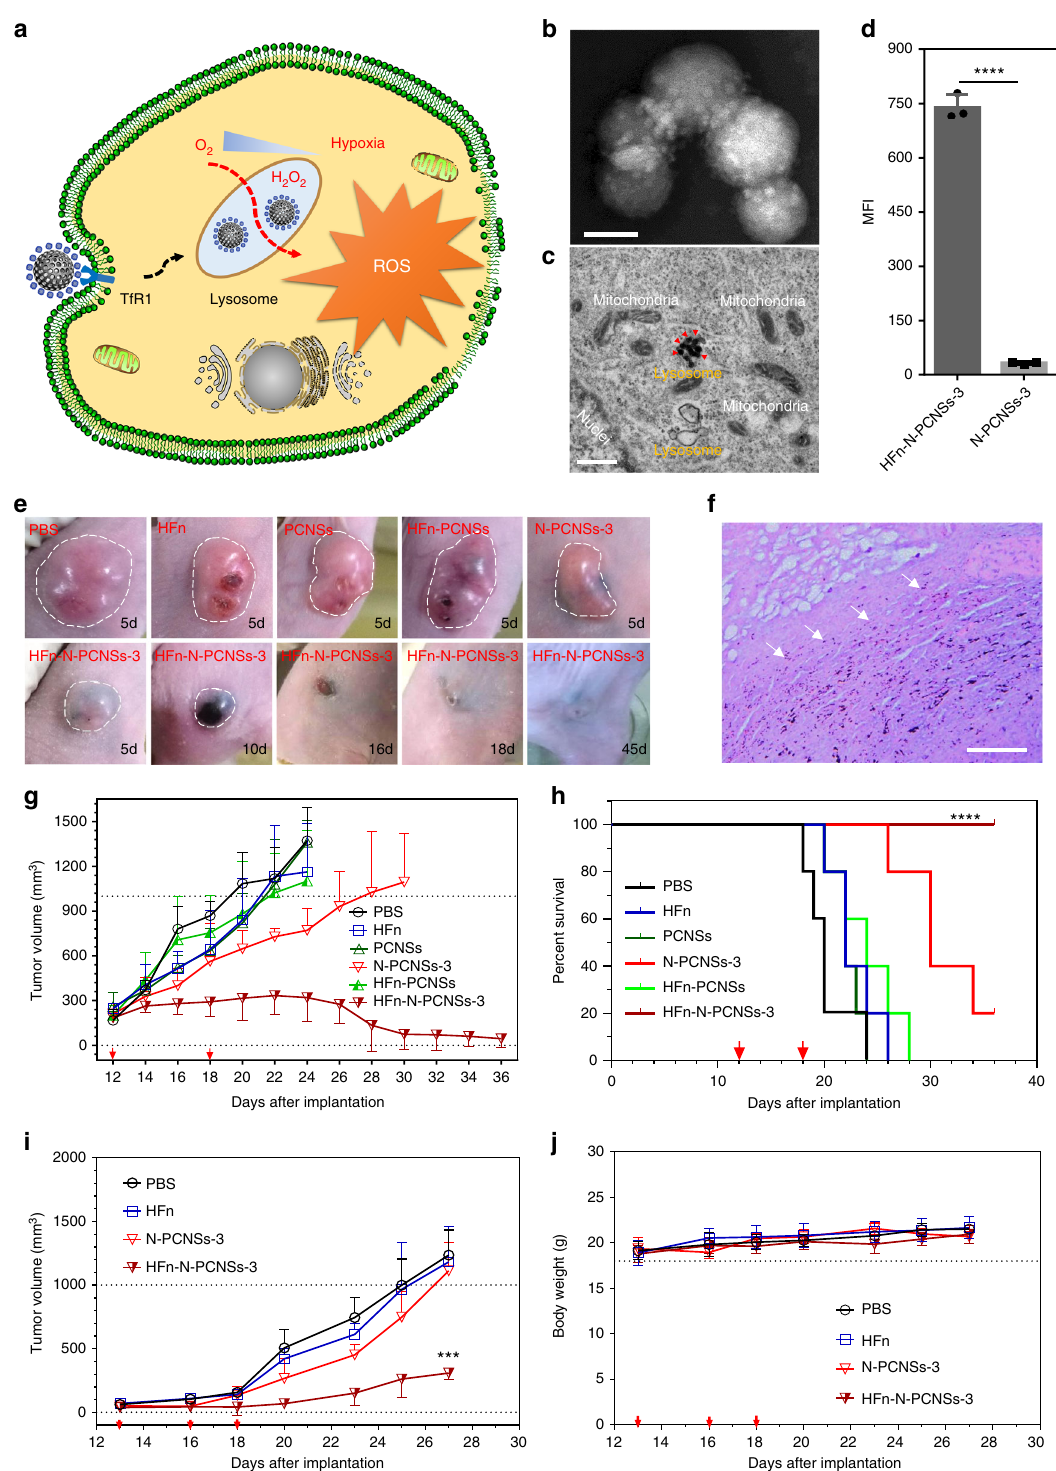
Fig. 4 Tumor therapy based on N-PCNSs using HFn coordination. a Schematic for N-PCNSs induced tumor cell destruction via ferritin-mediated speci fi c delivery. b TEM image of HFn assembled onto N-PCNSs. Scale bar: 50 nm. c TEM image of cancer cells treated with HFn-PCNSs. Red arrows indicate the position of HFn-PCNSs. Scale bar: 500 nm. d Quanti fi cation of HFn-enhanced internalization of N-PCNSs by fl ow cytometry analysis ( n = 3). Statistical signi fi cance is assessed by unpaired Student ’ s two-sided t -test compared to the control group. **** p < 0.0001. e Tumor morphology and progress with HFn-N-PCNSs treatment ( n = 5). f Accumulation of N-PCNSs in tumors. White arrow: edge of the tumor area. Scale bar: 200 µ m. g Tumor volume after i.t . treatment with HFn-N-PCNSs ( n = 5). h Survival results of tumor therapy with HFn-N-PCNSs i.t. treatment ( n = 5). Asterisks indicate **** p < 0.0001 for HFn-N-PCNSs-3 group compared with control groups (Kaplan – Meier). i Tumor volume after i.v. treatment with HFn-N-PCNSs ( n = 5). Statistical signi fi cance is assessed by unpaired Student ’ s two-sided t -test compared to the control groups. *** p < 0.001. j Body weight changes of treated mice following i.v. injection of HFn-N-PCNSs ( n = 5). Mean values and error bars are de fi ned as mean and s.d., respectively. i.t. intratumorally, i.v.